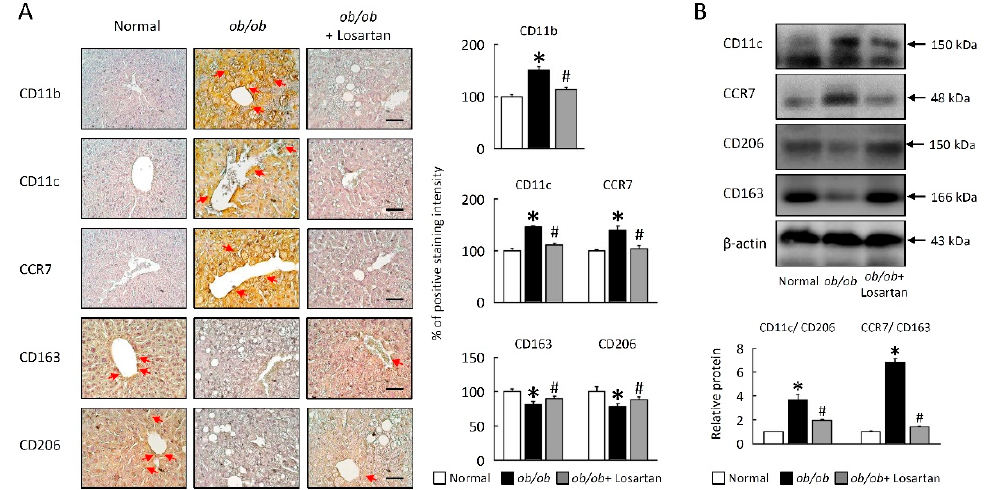
Figure 8. Losartan regulated macrophage polarization in liver. ( A ) Representative CD11b, CD11c, CCR7, CD163, and CD206 staining of liver. Red arrow highlights the positive staining. Scale bar: 100 µ m. Tissue staining, as quantified by either stain intensity, is represented on the left-hand vertical axis in each graph. ( B ) Quantification of CD11c, CCR7, CD206, and CD163 protein levels by Western blot of liver. Below graphs indicate quantification relative to β -actin. Ratio of CD11c/CD206 and CCR7/CD163 in liver. For each animal group, n = 5. All values represent the mean ± SEM. Data were analyzed by Student’s t test. * p ≤ 0.05, normal vs. ob/ob ; # p ≤ 0.05, ob/ob vs. ob/ob + Losartan.